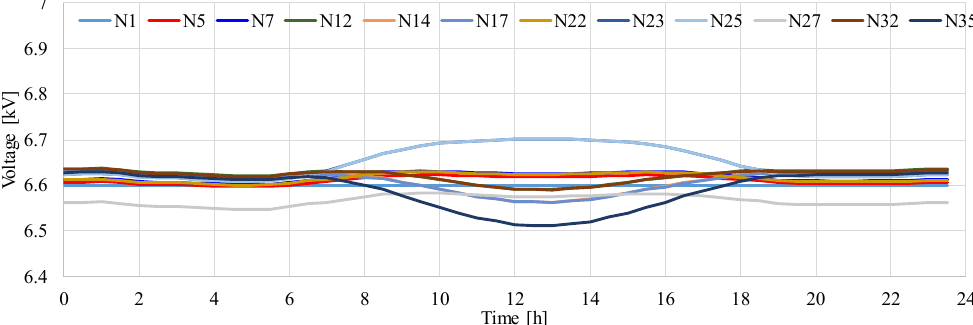
Figure 9. Time variation in voltage at MV distribution system without PCS in the LV distribution system.